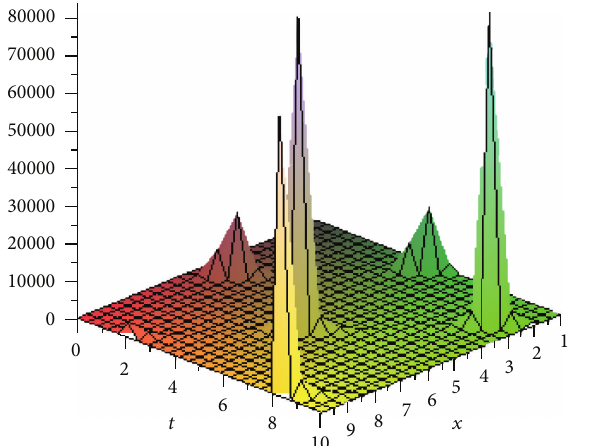
Figure 6: The solution 𝑊 4 in (37) with 𝛾 = 4/5 , 𝑘 = 𝑐 = 𝜎 = 𝑏 2 = = 1 , 𝜇 = −1 , 𝜉 𝑓 2